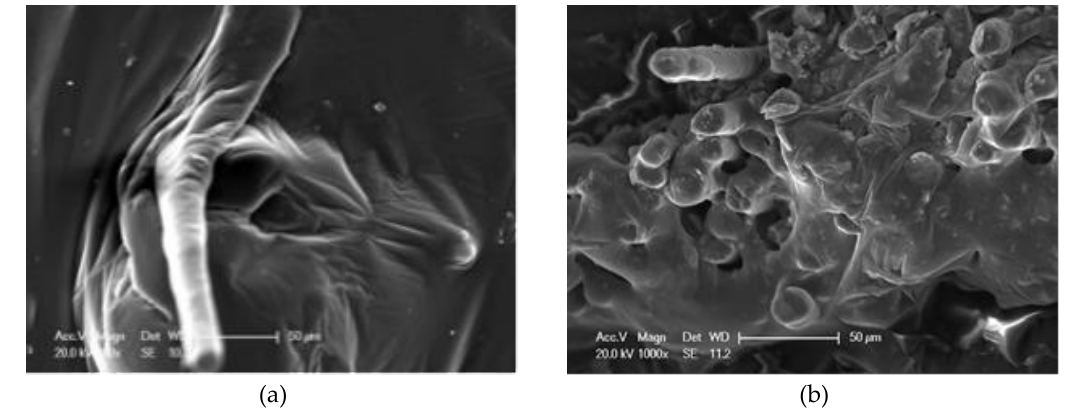
Figure 15. Micro images of mixed-fiber-reinforced asphalt (MFRA) (3:0): ( a ) image 1, 1000×; ( b ) image 2, 1000×.